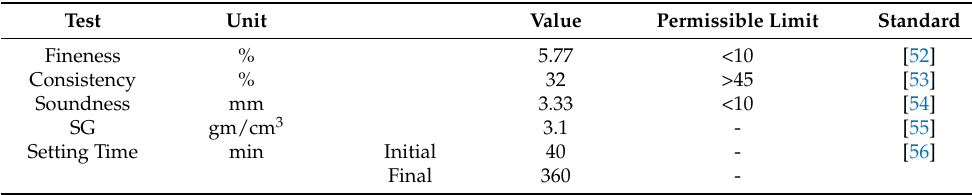
Table 2. Mechanical Characteristics of